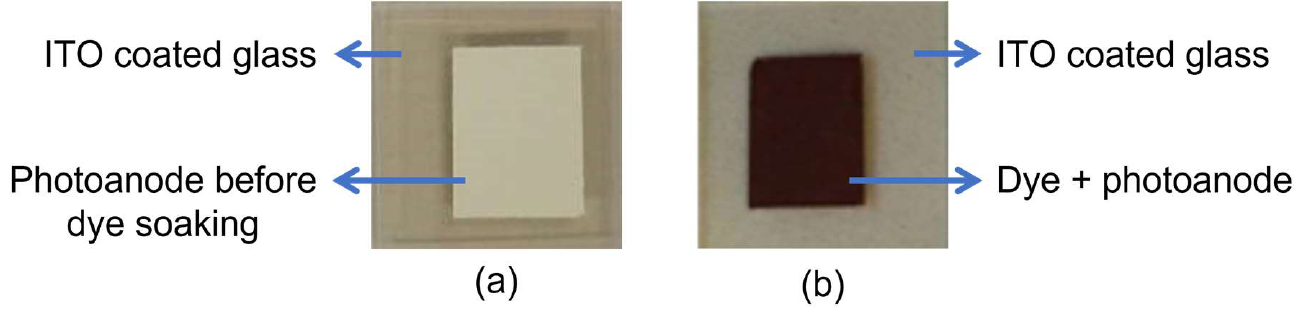
Figure 5. The working electrode ( a ) before the dye soaking process and ( b ) after 2 h of the dye coating process.